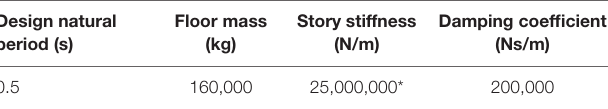
TABLE 3 | Initial model parameters of the target structural